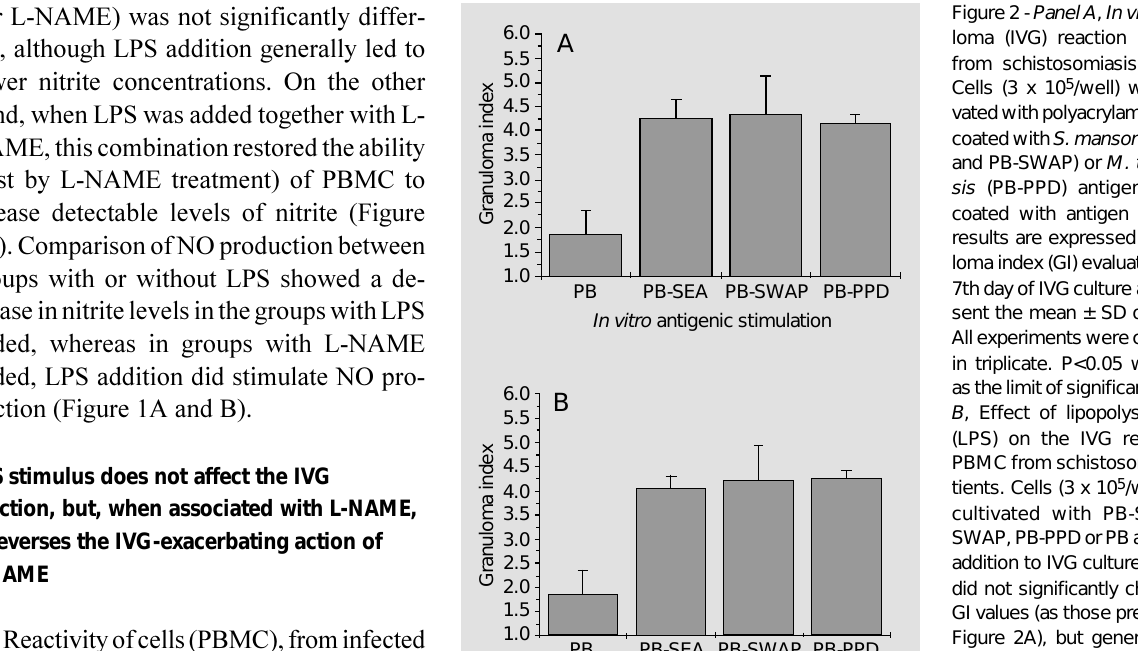
Figure 2 - Panel A , In vitro granu- loma (IVG) reaction of PBMC from schistosomiasis patients. Cells (3 x 10 5 /well) were culti- vated with polyacrylamide beads coated with S. mansoni (PB-SEA and PB-SWAP) or M. tuberculo- sis (PB-PPD) antigens or not coated with antigen (PB). The results are expressed as granu- loma index (GI) evaluated on the 7th day of IVG culture and repre- sent the mean ± SD of N = 10. All experiments were carried out in triplicate. P<0.05 was taken as the limit of significance. Panel B , Effect of lipopolysaccharide (LPS) on the IVG reaction of PBMC from schistosomiasis pa- tients. Cells (3 x 10 5 /well) were cultivated with PB-SEA, PB- SWAP, PB-PPD or PB alone. LPS addition to IVG culture (1 µg/ml) did not significantly change the GI values (as those presented in Figure 2A), but generally there was a mild decrease in the IVG reaction as shown by lower mean GIs compared to Figure